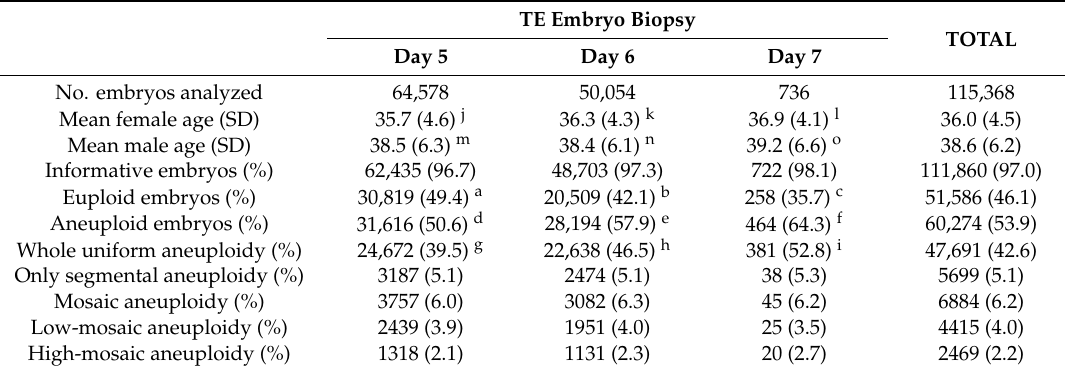
Table 1. NGS results of 27,436 PGT-A cycles performed in TE biopsies. TE Embryo